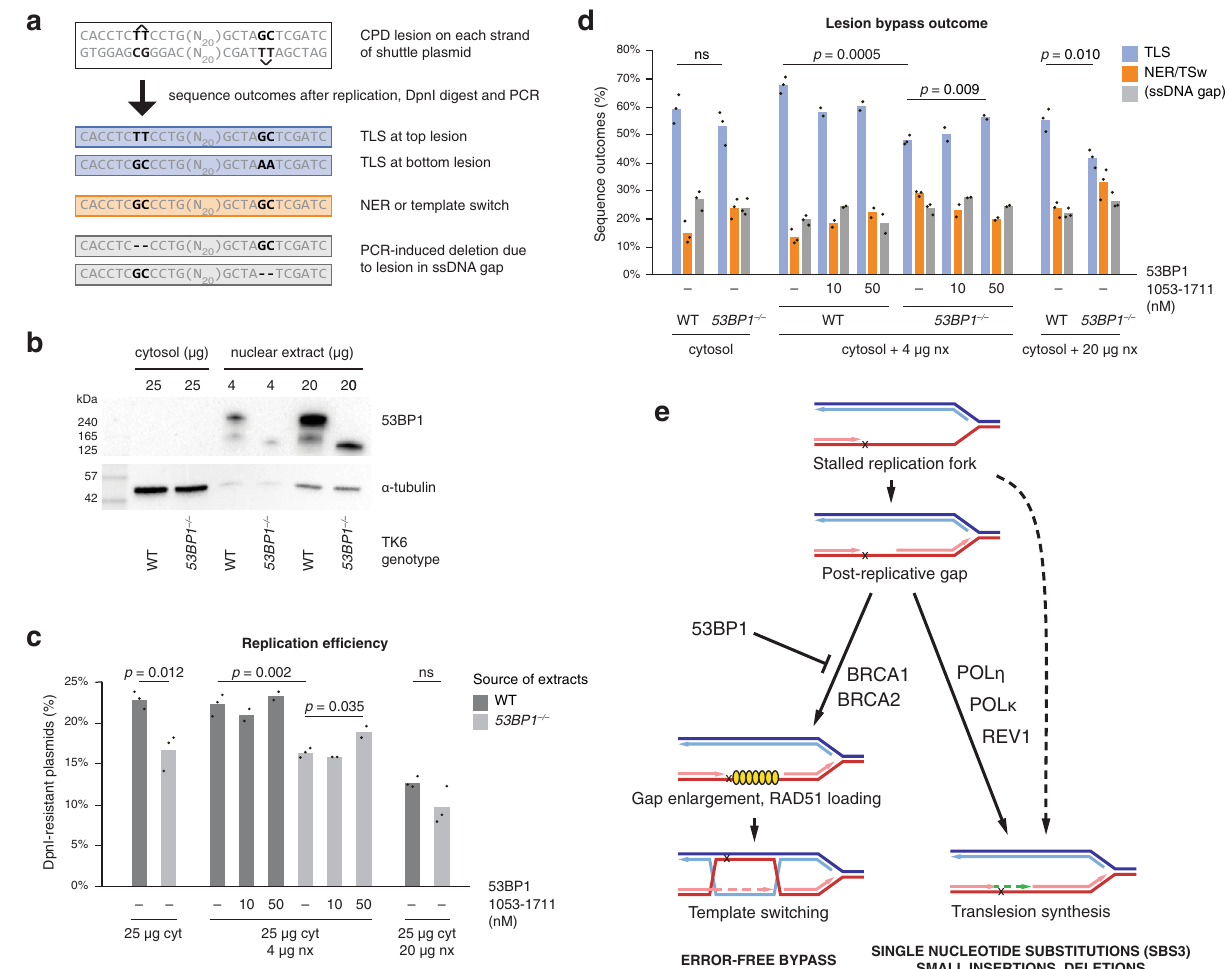
Template switching SINGLE NUCLEOTIDE SUBSTITUTIONS (SBS3) SMALL INSERTIONS, DELETIONSERROR-FREE BYPASS Fig. 6 53BP1 promotes TLS in human cell extracts. a Sequence detail of the lesion-containing shuttle plasmid used in in vitro DNA replication reactions in the presence of SV40 T antigen, indicating the staggered position of TT(CPD) lesions on each strand. Below, typical sequence outcomes detected in PCR products of DpnI-digested replicated DNA are shown (top strand sequence), together with the responsible mechanisms. CPD, cyclobutyl pyrimidine dimer, TLS, translesion synthesis, NER, nucleotide excision repair, ssDNA, single-stranded DNA. b Western blot of 53BP1 in samples of cytosolic and nuclear extract from WT or 53BP1 – / – human TK6 cells as used in subsequent experiments. A representative image of three experiments is shown. c The ef fi ciency of replication, as measured by the ratio of quantitative PCR products spanning 3 or 0 DpnI sites on the lesion-containing plasmids recovered from 10 μ l reactions that contained the indicated amounts of cytosolic (cyt) or nuclear extracts (nx) from WT or 53BP1 – / – TK6 cells and the indicated concentrations of a recombinant 53BP1 fragment. d Sequence outcomes in the replication reactions also shown in panel ( c ), measured using sequence-speci fi c quantitative PCR on longer PCR products derived from DpnI-resistant replicated lesion-containing plasmids which were incubated in the indicated extracts. TSw, template switching. Means and individual values of independent experiments are shown in ( c , d ), the signi fi cance of tested differences is indicated (ns not signi fi cant, unpaired two-sided t -test, n = 3 independent experiments except n = 2 for the reconstitution experiments). e A schematic model of the choice between DNA damage bypass mechanisms that in fl uence mutagenesis in the presence or absence of BRCA1/2. Yellow symbols represent RAD51. Source data are provided as a Source Data fi